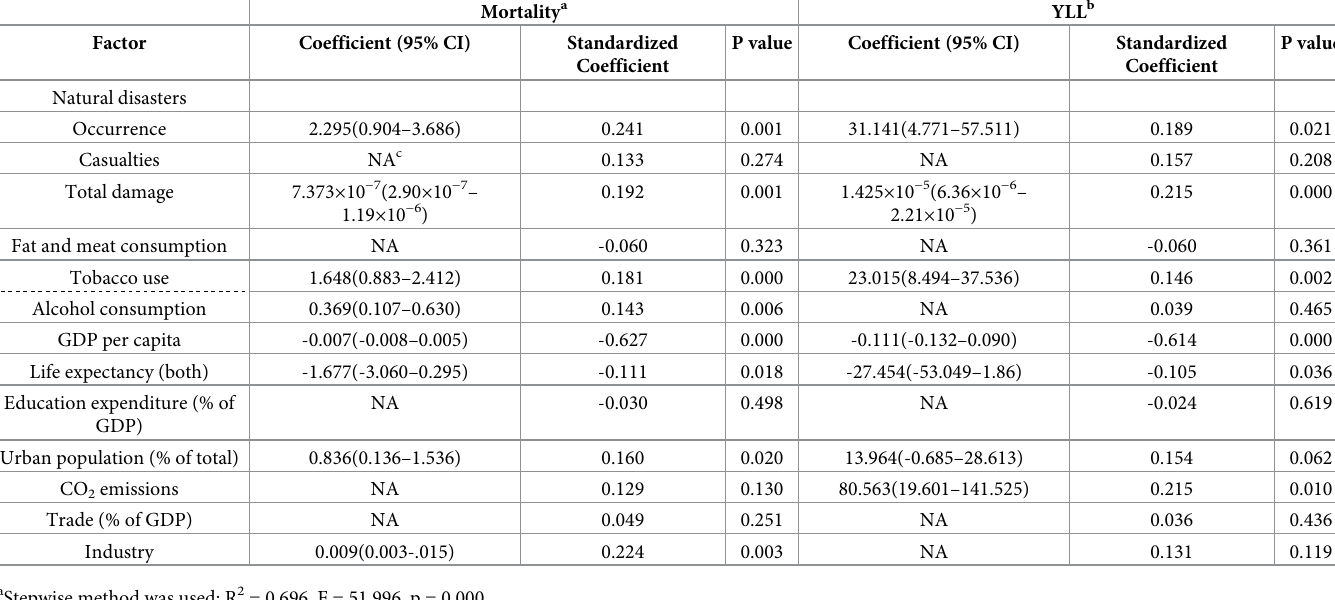
Table 5. Multivariate linear regression-derived coefficients of the associations of natural disasters and socioeconomic variables with IHD mortality and YLL rates among both sexes from 1990 to 2017 in 193 countries, weighted by